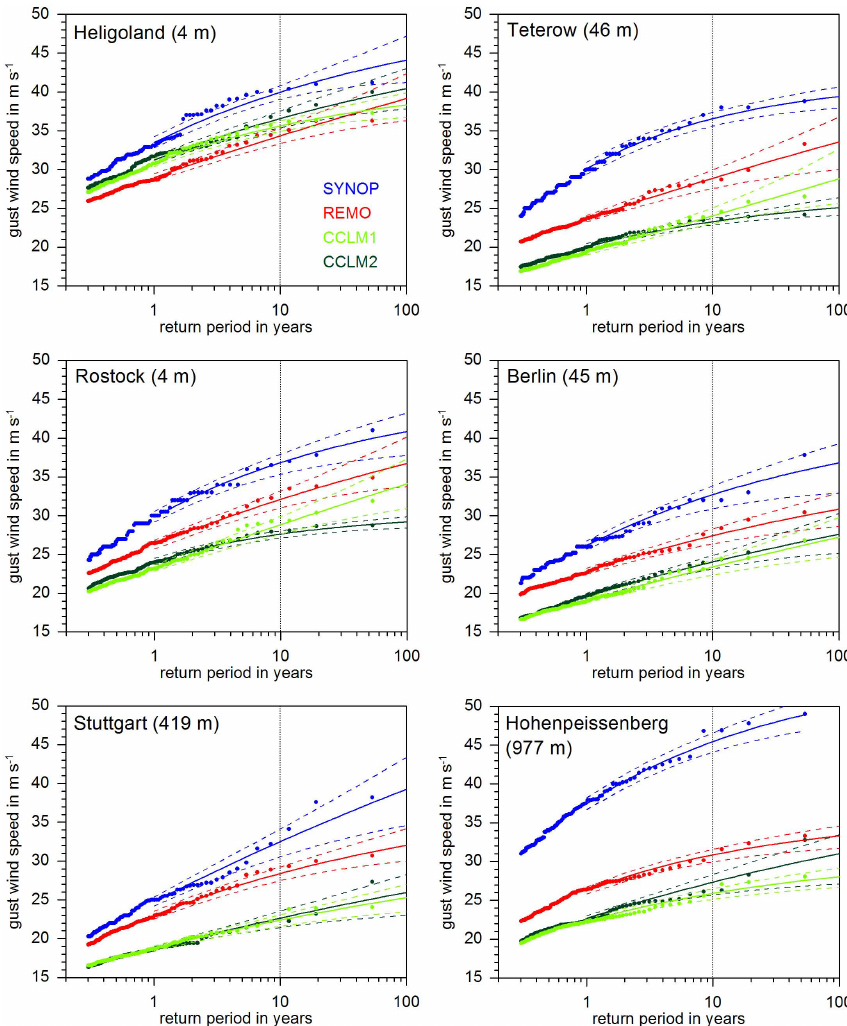
Fig. 7. Gust wind speed as a function of the return period with 90% confidence intervals for selected observation sites of Heligoland, Teterow, Rostock, Berlin, Stuttgart, and Hohenpeissenberg (station height indicated; see Fig. 1 for the locations) according to observations, REMO, and CCLM